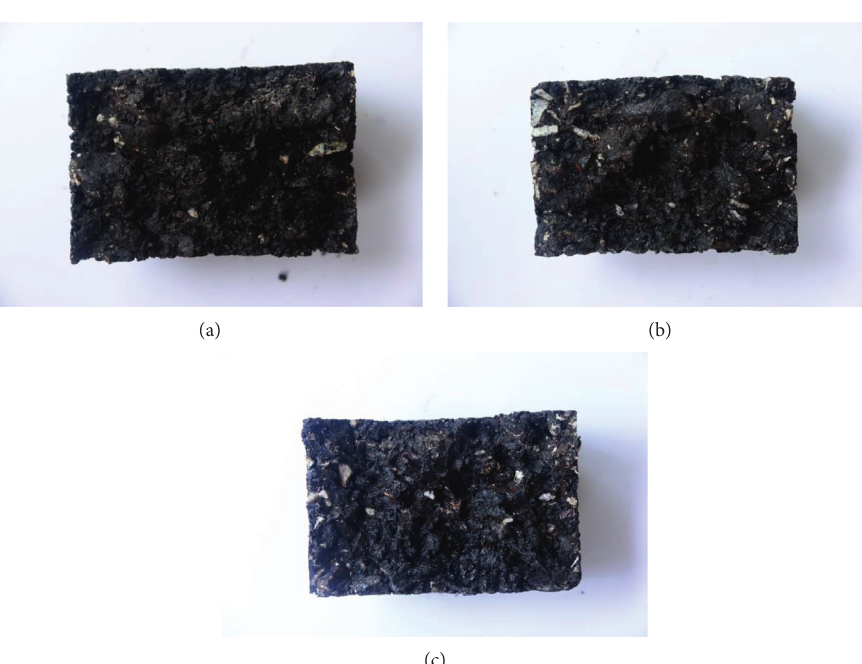
Figure 4: Sample specimen of (a) Dry-WP170, (b) 1FT-WO170, (c) 3FT-WP170.